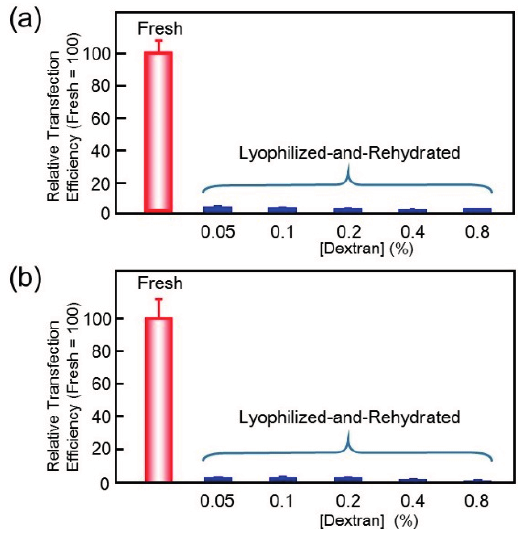
Figure 4. Effect of dextran concentration on gene expression levels after lyophilizaion-and-rehydration. ( a ) DNA/(PEI “Max”)/HA complexes (1:12:12); ( b ) DNA/(PEI “Max”)/CS complexes